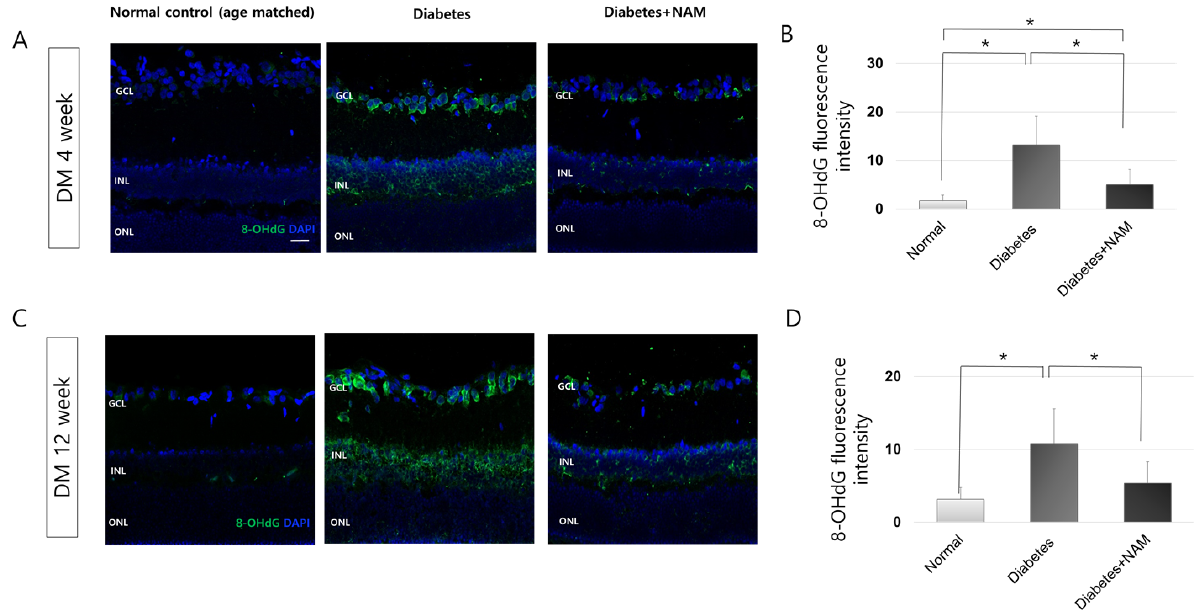
Figure 5. Oxidative DNA damage. 8-Hydroxy-2 ′ -deoxyguanosine (OHdG) expression was observed in the ganglion cell layer (GCL) at 4 weeks after injection of streptozotocin. 8-OHdG immunostaining was extended to the inner nuclear layer at 12 weeks after onset of diabetes ( A , C ). Nicotinamide treatment attenuated increased 8-OHdG labeling by diabetes at 4 and 12 weeks after induction of diabetes ( p = 0.002, 0.005, respectively; ( B , D )). Scale bar = 20 µ m. DM, diabetes mellitus; NAM, nicotinamide. GCL, ganglion cell layer. INL, inner nuclear layer. ONL, outer nuclear layer. *, significantly different as indicated ( p <